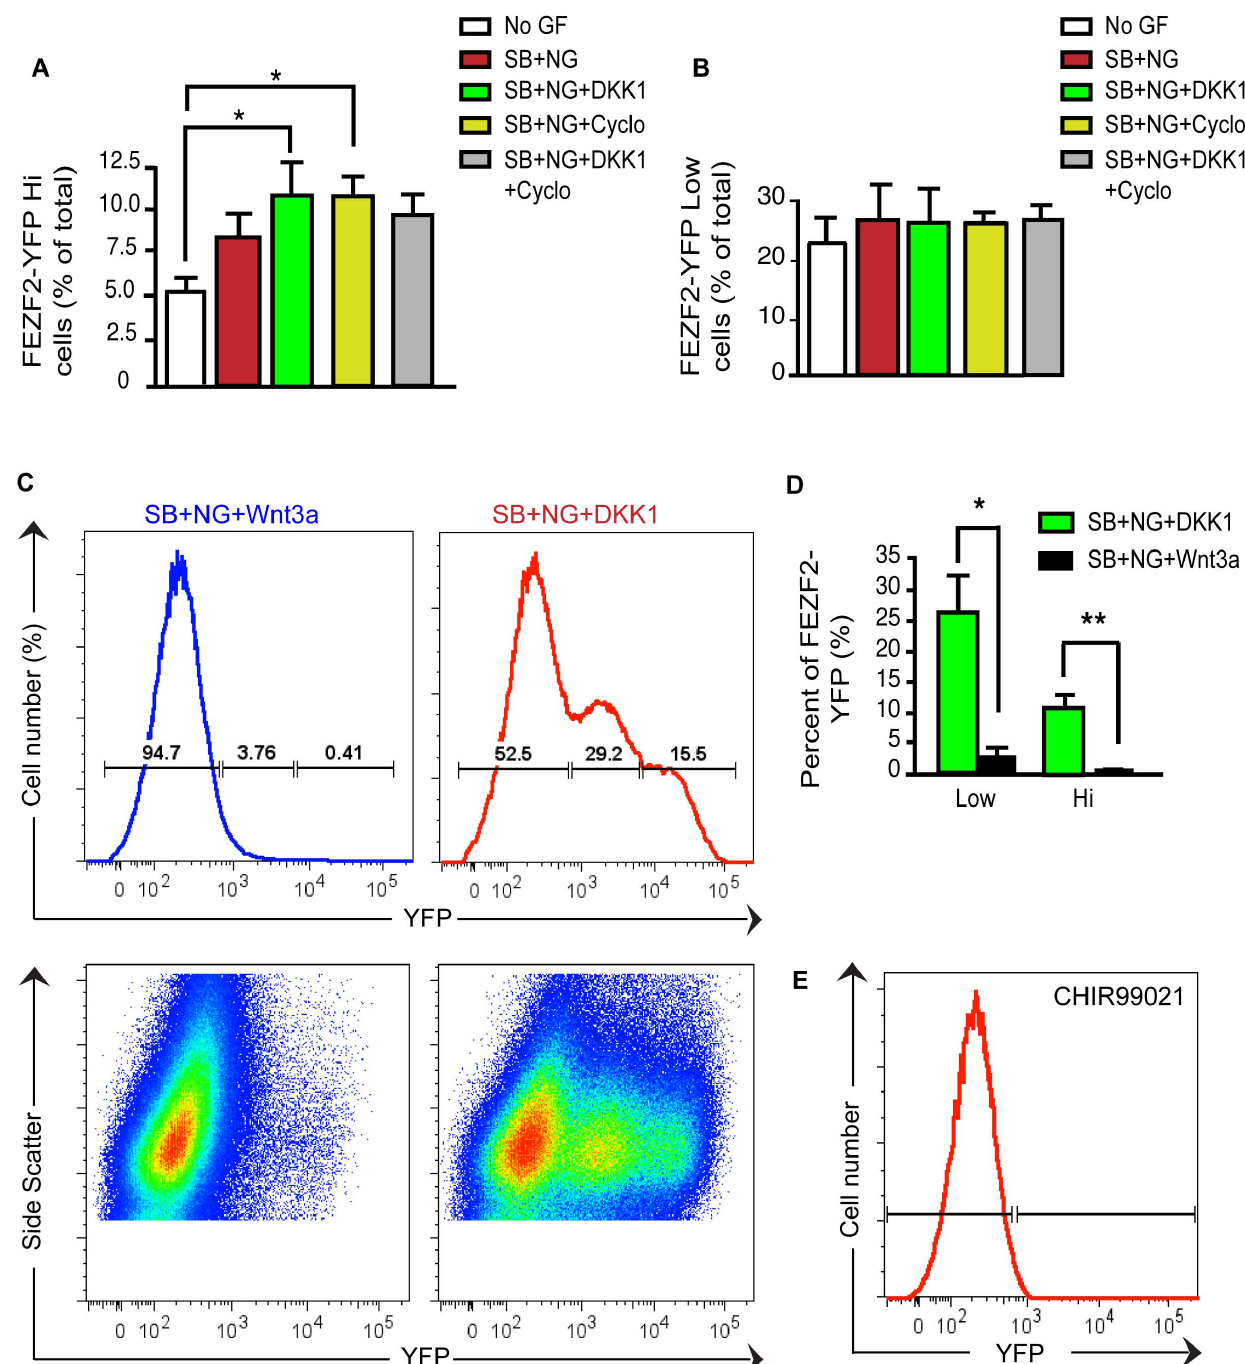
Figure 4. TGFß/BMP/Wnt-Shh triple inhibition activates Fezf2 expression in hESCs. ( A ) Quantification by FACS of differentiated h Fezf2 -YFP cells under different conditions shows a 2.2 fold increase in efficiencies in generating h Fezf2 -YFP Hi subpopulation using SB + NG + DKK1 and SB + NG + Cyclopamine treatments compared to a no growth factor control F(4,20)=13.74) p=0.0235. Error bars represent standard error of mean, sem (n=4). p and F values were assessed by one-way ANOVA with Tukey’s post-test). The efficiency of generating Fezf2 -GFP Hi cells was in the range: 5– 10.8%, n=4 per condition, quantified by FACS. ( B ) FACS analysis of differentiated h Fezf2 -YFP cells shows that the efficiencies to generate h Fezf2 - YFP Low subpopulation were similar under different conditions (range: 23–26.7%, n=4) but yielded an overall higher percentage than the Fezf2 -GFP Hi population. ( C ) Representative FACS histograms and FACS dot plots showing differentiated h Fezf2 -YFP cells under Wnt activation (Wnt3a) and Wnt inhibition (DKK1). ( D ) Quantification of the efficiencies of generating h Fezf2 -YFP Hi and h Fezf2- YFP Low subpopulations under Wnt activation and Wnt inhibition conditions. Student t-test, unpaired, two-tailed, Welch’s corrected t=3.91; p=0.0298 (for low) and t=6.329; p=0.0080 (for high). ( E ) FACS histogram showing inhibition of both h Fezf2 -YFP Hi and h Fezf2- YFP Low populations under treatment with the Wnt agonist CHIR99021 at day 30.